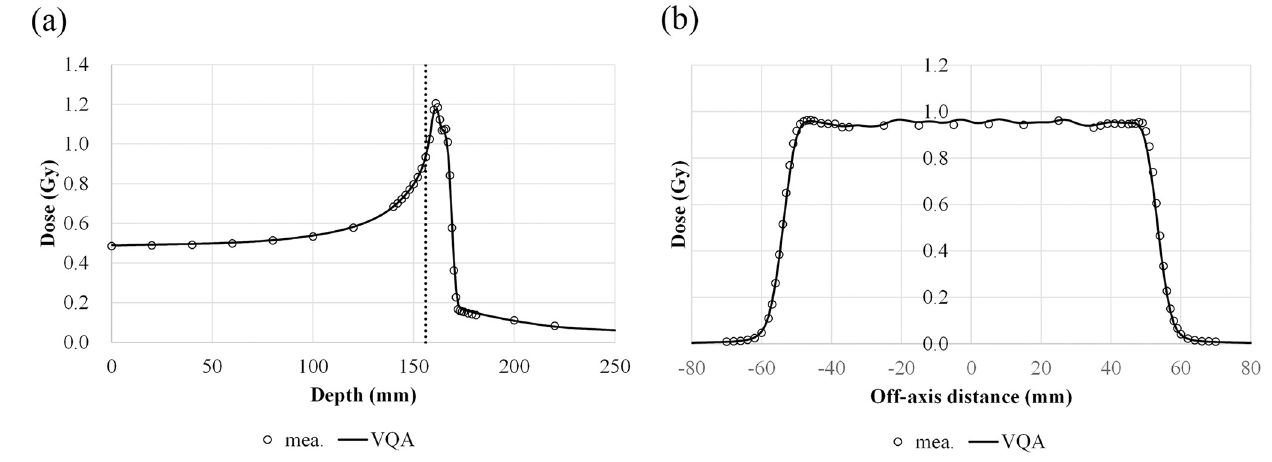
Fig 8. Comparison of the TPS-calculated and measured dose profiles for a field size of 100 × 100 mm 2 with a 6-mm SOBP. (a) The depth–dose profile along the central axis; the vertical dashed line represents the position of the measured lateral profile. (b) The lateral-dose profile at 156-mm depth; the circles and solid lines are the measured and calculated profiles, respectively.